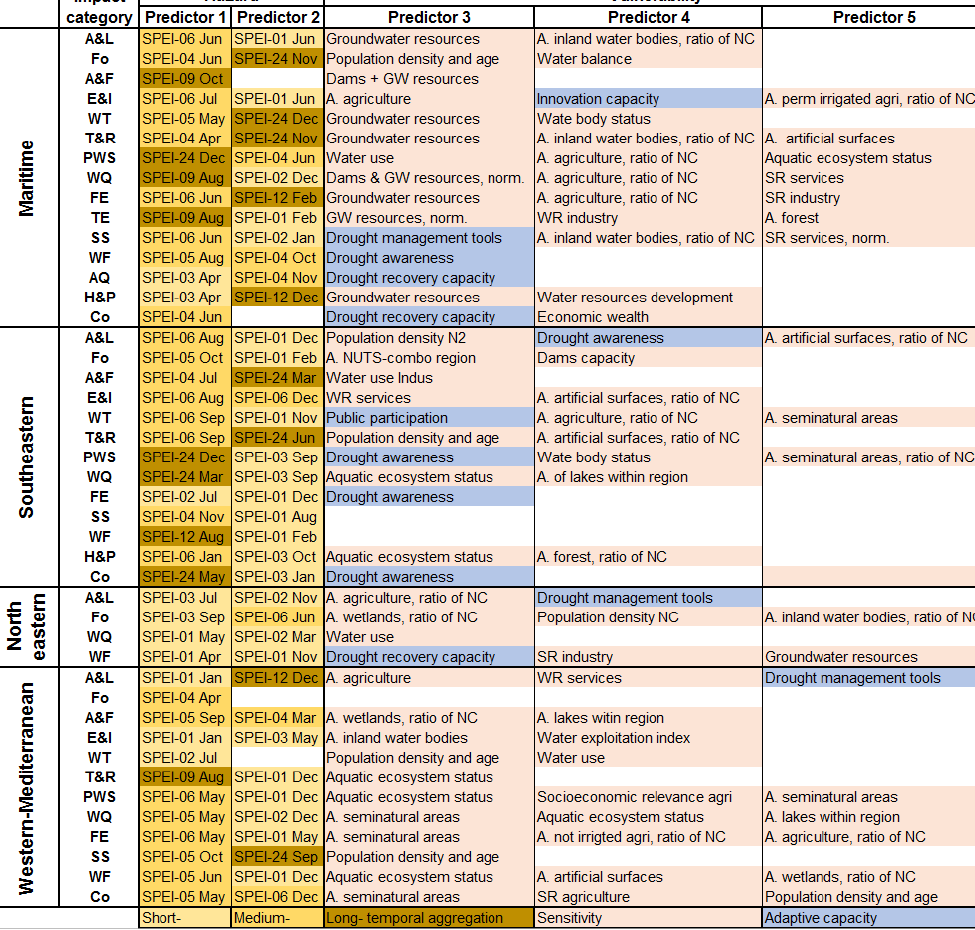
Figure 3. Selected of the best-performing predictors, yellow: SPEI with short temporal accumulation, light yellow to brown: SPEI with increasing temporal aggregation (short, medium, and long temporal accumulation), red: vulnerability factors associated with sensitivity, blue: vulnerability factors associated with adaptive capacity, A. = Area of, GW = Groundwater, norm. = normalised, NC = NUTS-combo region, N2 = NUTS-2 region, SR = Socioeconomic relevance, WR = Water use